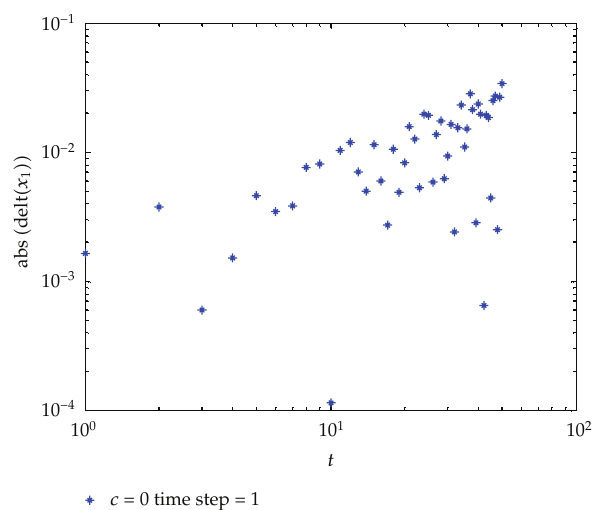
Figure 12: The log-log plot of the error between the ECM and RK.